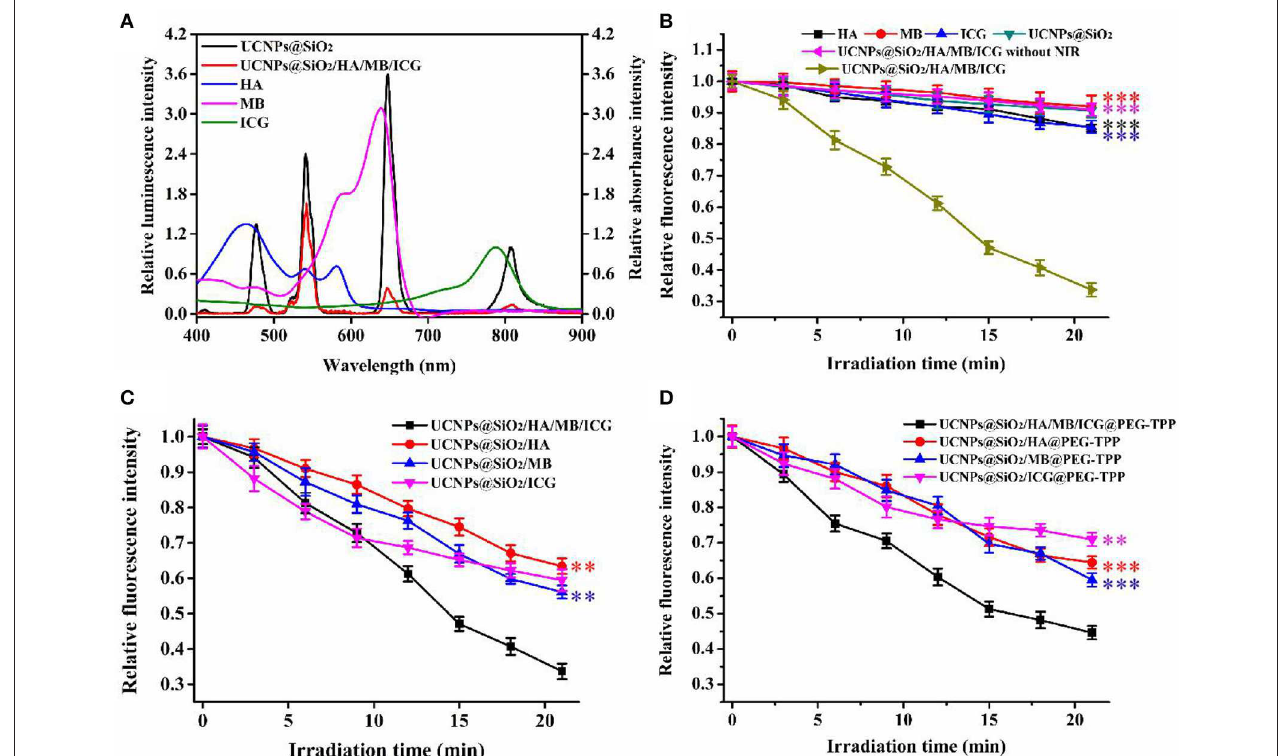
FIGURE 3 | (A) Relative luminescence intensity of UCNPs@SiO 2 and UCNPs@SiO 2 /HA/MB/ICG, relative absorbance value of HA, MB and ICG; (B) ROSs production of HA, MB, ICG, UCNPs@SiO 2 , UCNPs@SiO 2 /HA/MB/ICG under the irradiation of NIR laser (1.5 W/cm 2 ), and UCNPs@SiO 2 /HA/MB/ICG without the irradiation; (C) ROSs production of the prepared nanoprobe under the irradiation of NIR laser; (D) ROSs production of the TPP modified nanoprobes under the irradiation of NIR laser. Each time point was operated five times and error bars represent standard deviation ( n = 5). The data was analyzed by the T -test. ** p < 0.01 and *** p < 0.001.